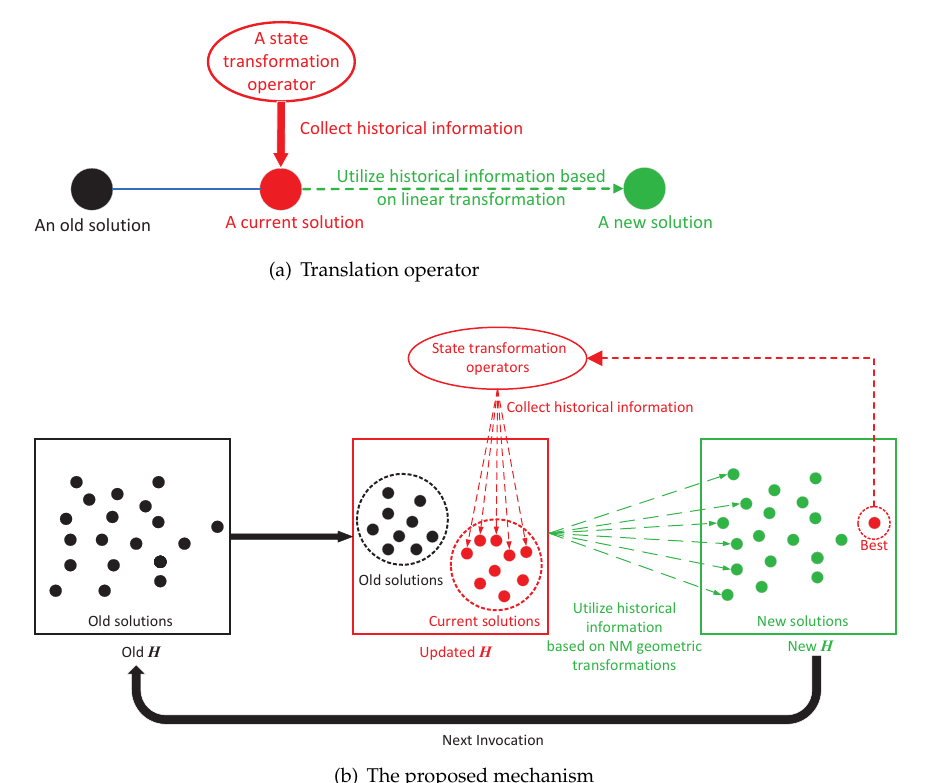
Figure 3. Comparison in collecting and utilizing historical